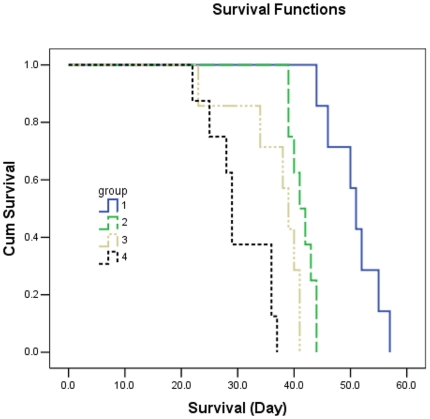
Kaplan-Meier survival analysis of liver-tumor-bearing
rabbits.Graph of the Kaplan-Meier method with the log-rank test shows a
significant survival benefit for the animals treated with ATON
embolization alone or plus hyperthermia compared with those in Groups 3
and 4.